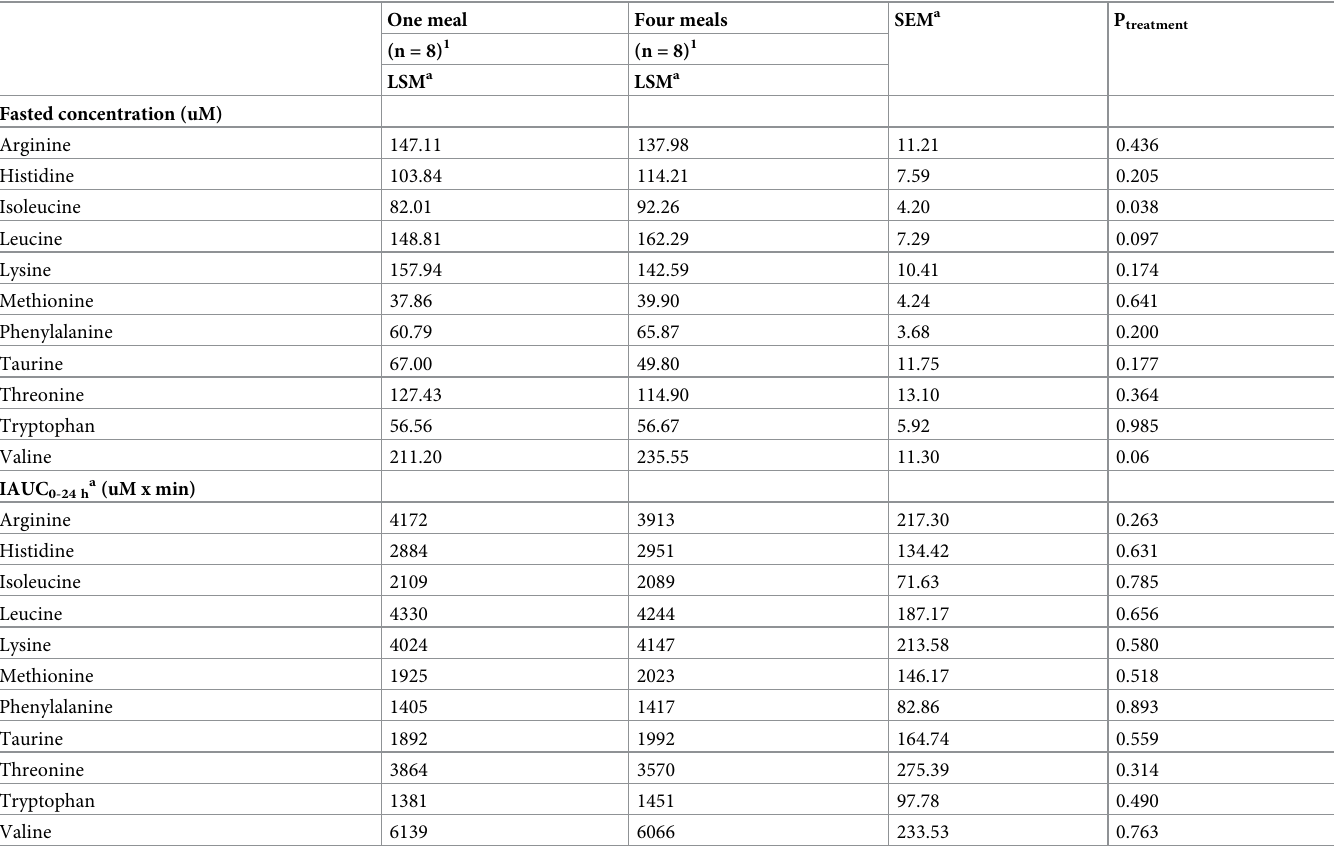
a LSM, least square means; SEM, standard error of the mean; IAUC, incremental area under the curve. 1 Eight cats were used and 4 of 8 repeated one of the two treatments, each mean represents 11 experimental